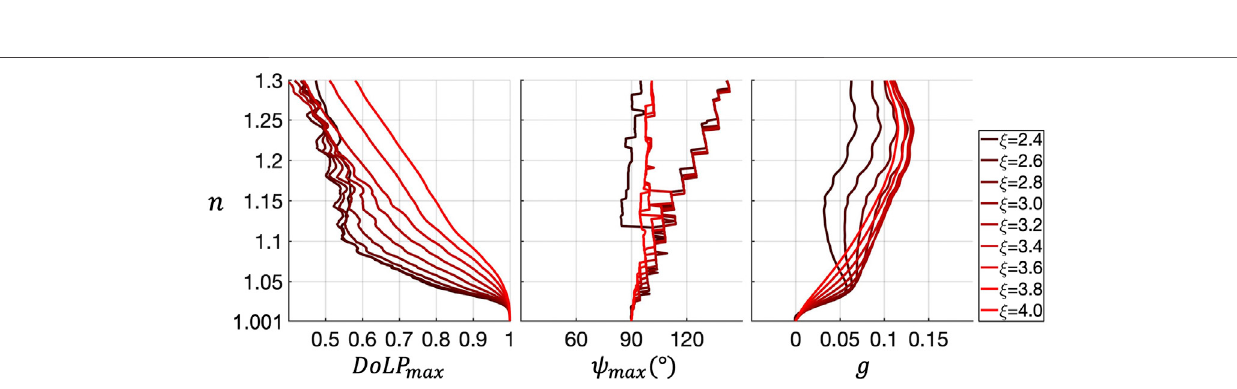
Frontiers in Remote Sensing |